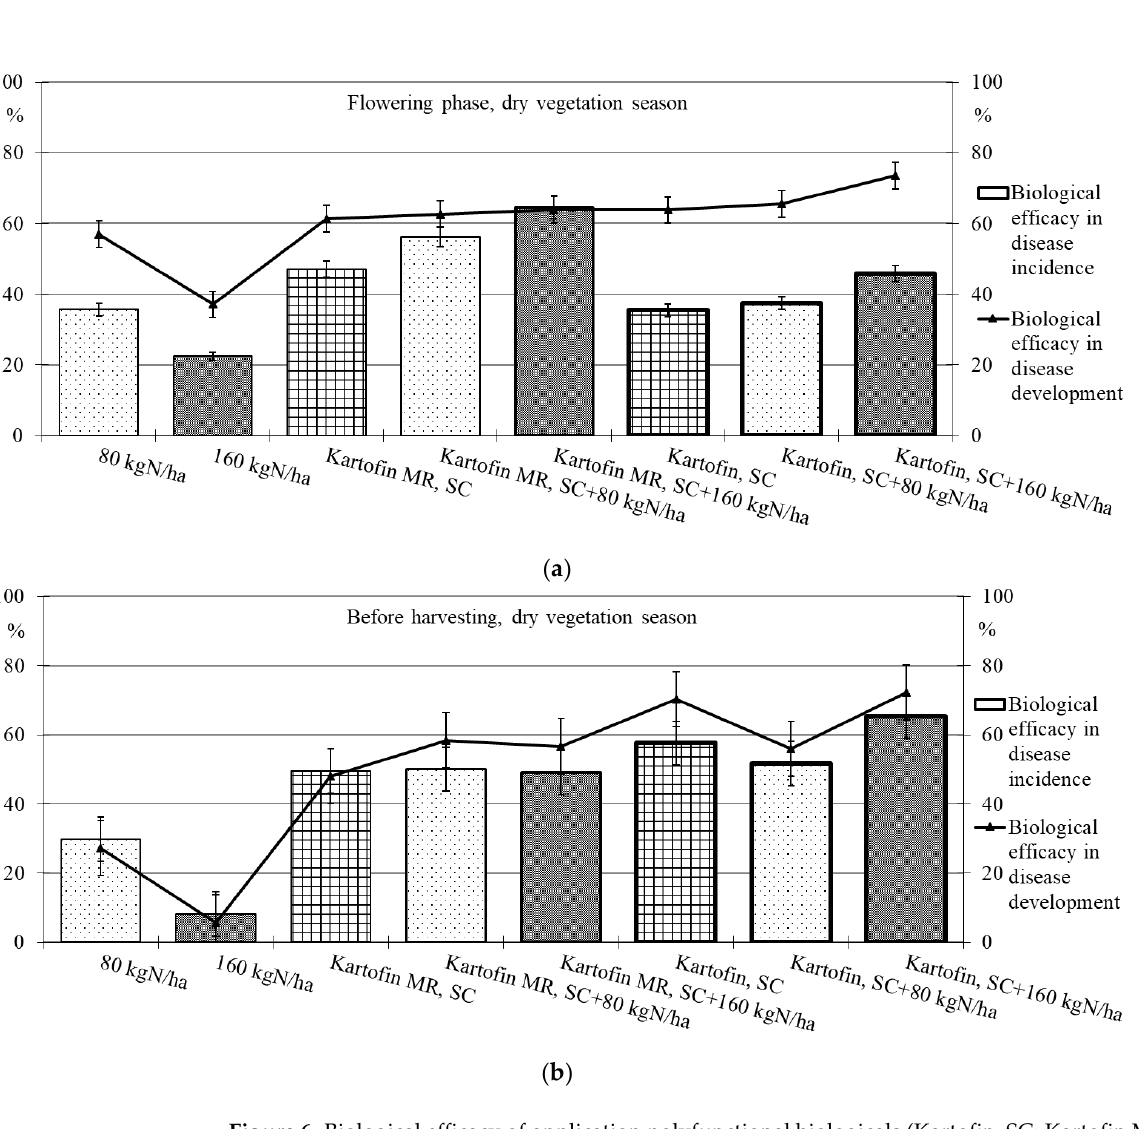
Figure 6. Biological efficacy of application polyfunctional biologicals (Kartofin, SC; Kartofin MR, SC) and organic fertilizer BIAGUM in doses of 80 and 160 kg N ha − 1 in the protection of the organic potatoes from dominant fungal diseases complex during dry vegetative season: ( a ) — in flowering phase; ( b ) — before harvesting.